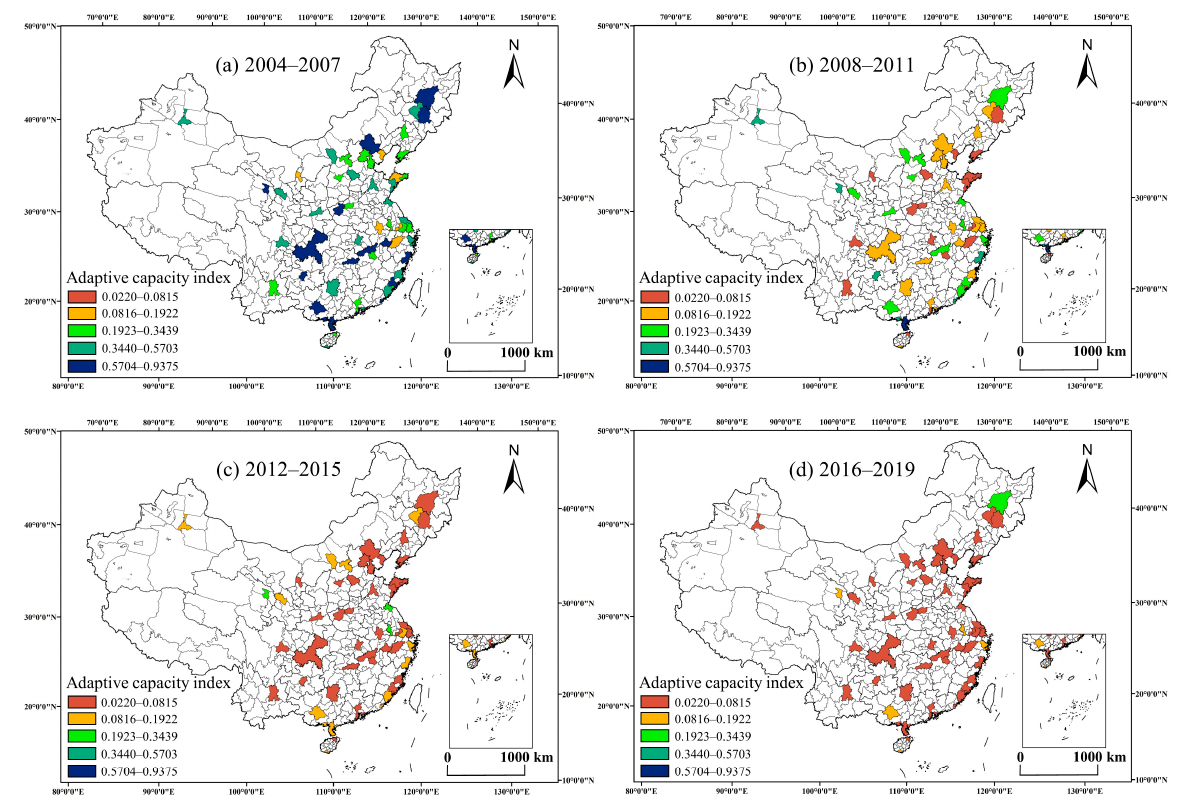
Figure 6. Spatiotemporal evolution of the adaptive capacity index (( a ) Average adaptive capacity index for 2004–2007 were shown; ( b ) Average adaptive capacity index for 2008–2011 were shown; ( c ) Average adaptive capacity index for 2012–2015 were shown; ( d ) Average adaptive capacity index for 2016–2019 were shown).